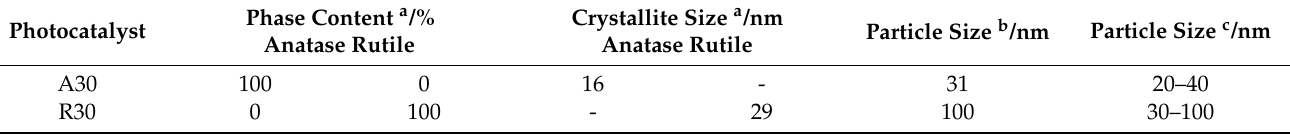
Table 1. Structure and texture characterization of photocatalysts used for the photocatalytic pharmaceuticals degradation. Photocatalyst